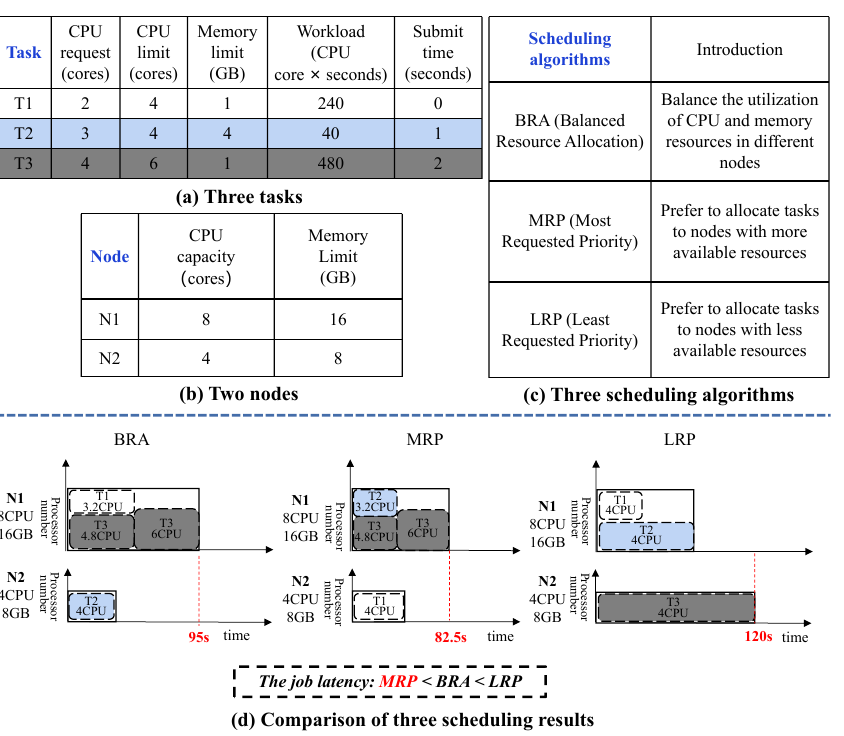
Figure 1. A scheduling example of three tasks in a job using three Kubernetes scheduling